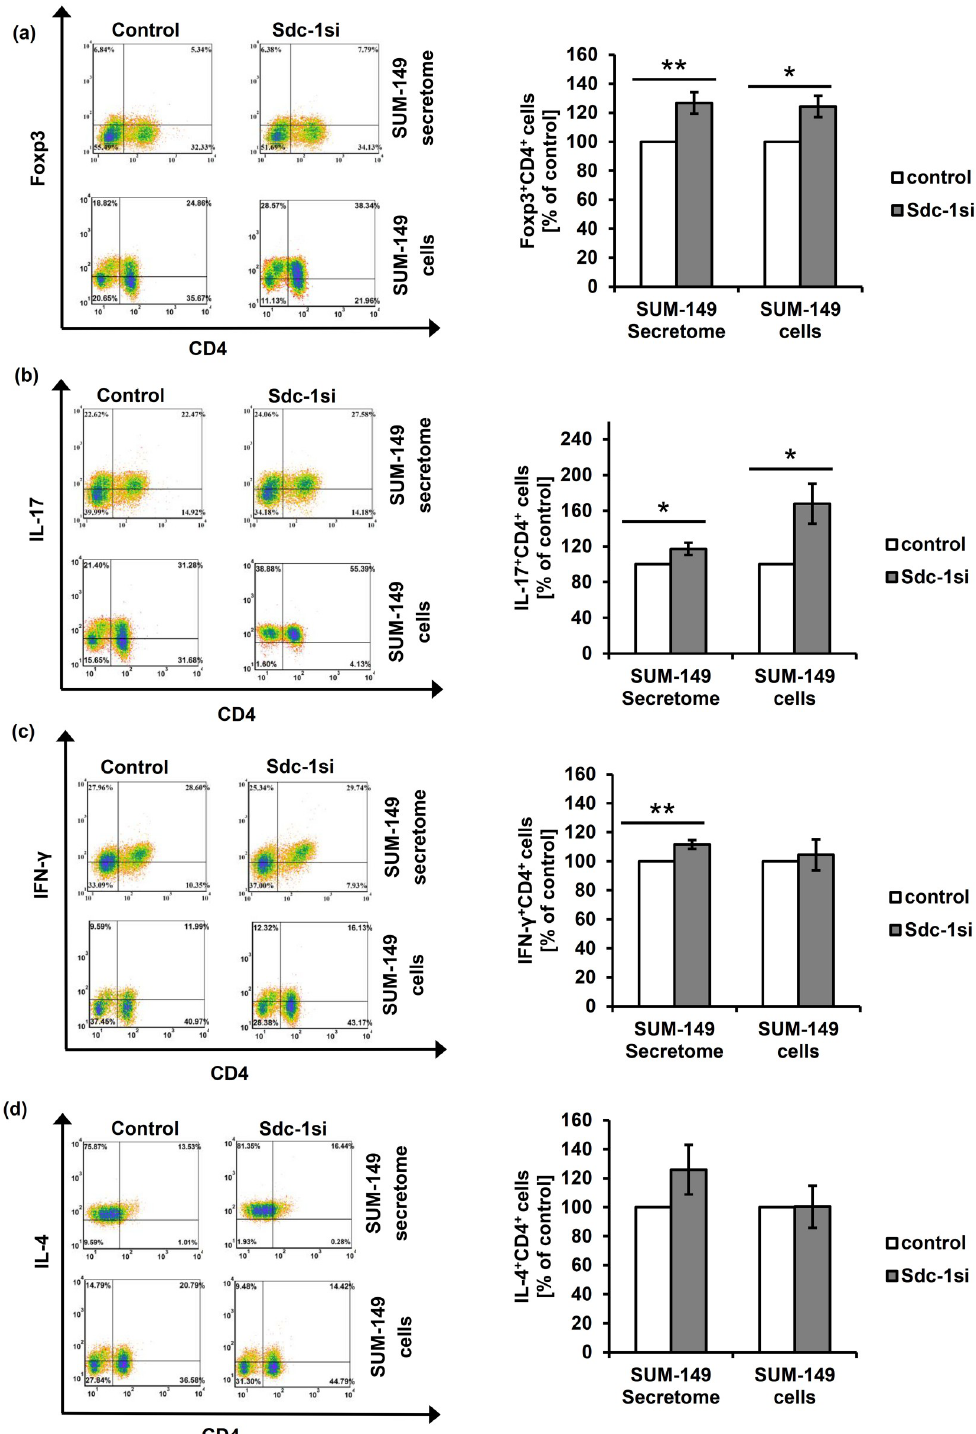
Fig 2. Effect of tumor Sdc-1 silencing on the polarization of T helper subsets of non-IBC patients. Lymphocytes isolated from axillary blood of non-IBC patients were either stimulated by the secretome of control and Sdc-1-silenced SUM-149 cells for 96 h or directly co-cultured with control and Sdc-1-silenced SUM-149 cells for 48 h. Lymphocytes were then stained with labeled antibodies against CD4-FITC, IFN- γ -PE, IL-4-PEcy7, IL-17-PE, and Foxp3-PEcy7. Relative to control cells, both Sdc-1-silenced SUM-149 cells and their secretome enhance (a) T reg (Foxp3 + CD4 + ) and (b) Th 17 (IL-